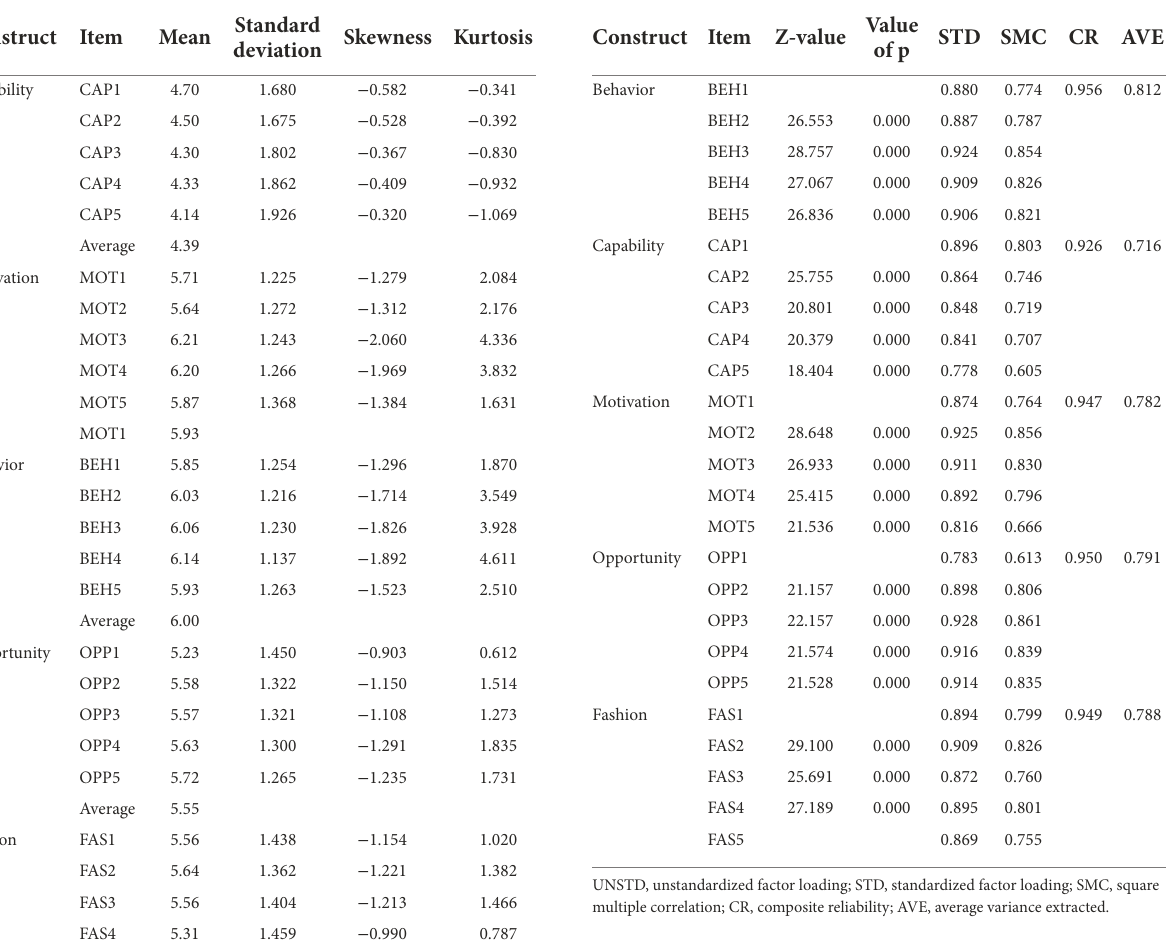
TABLE 2 Analysis of descriptive statistics. TABLE 3 Analysis of measurement model